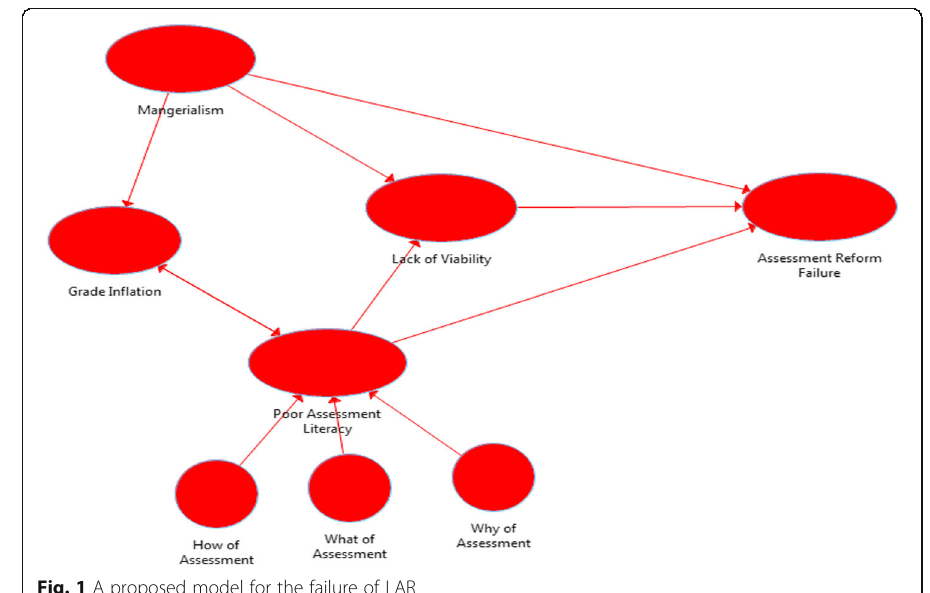
Fig. 1 A proposed model for the failure of